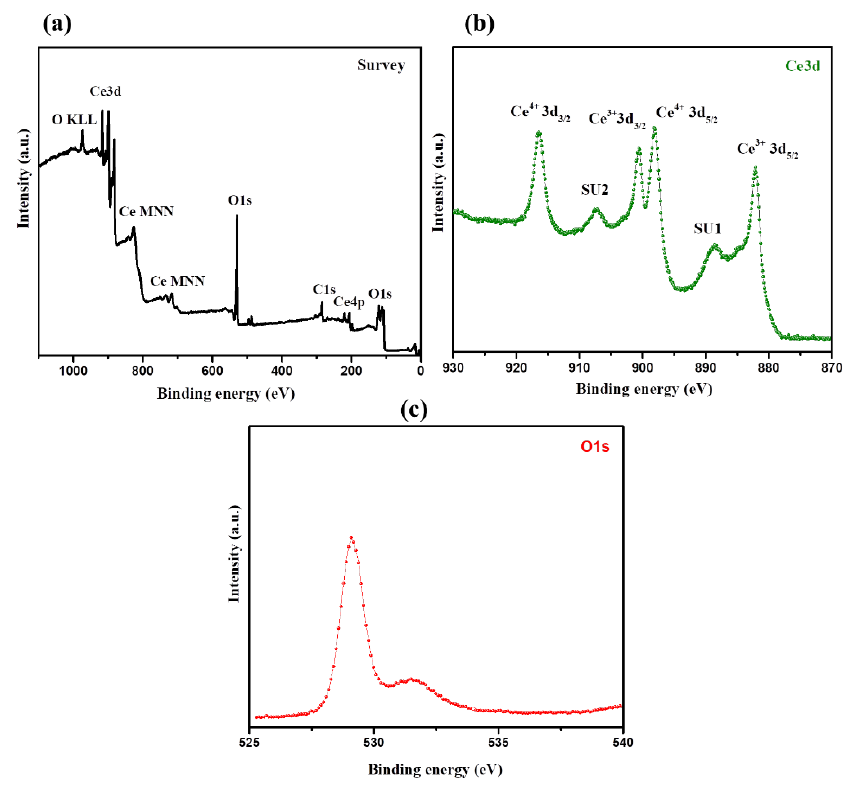
Figure 3. XPS of CeO 2 . Survey scan ( a ), Ce3d ( b ), and O1s ( c ) of the synthesized CeO 2 NPs.